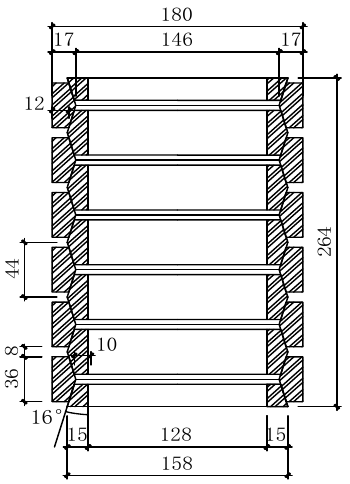
Figure 4. Structure size of ring spring (unit: mm).